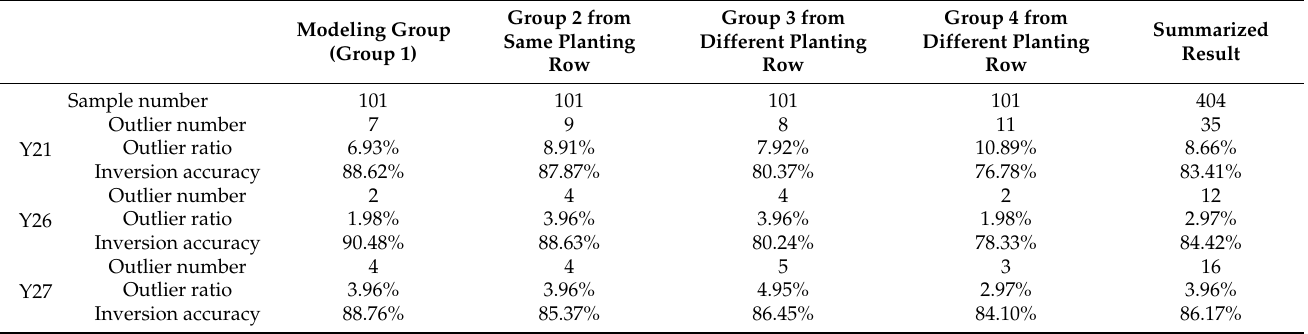
Table 6. Comparison of inversion effects of the piecewise inversion models of Y26 and Y27 to Y21. Modeling Group (Group